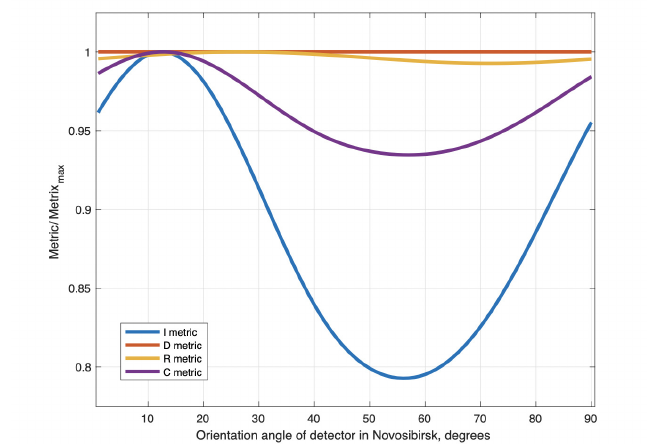
Figure 3. Dependence of all criteria on orientation angle of detector in